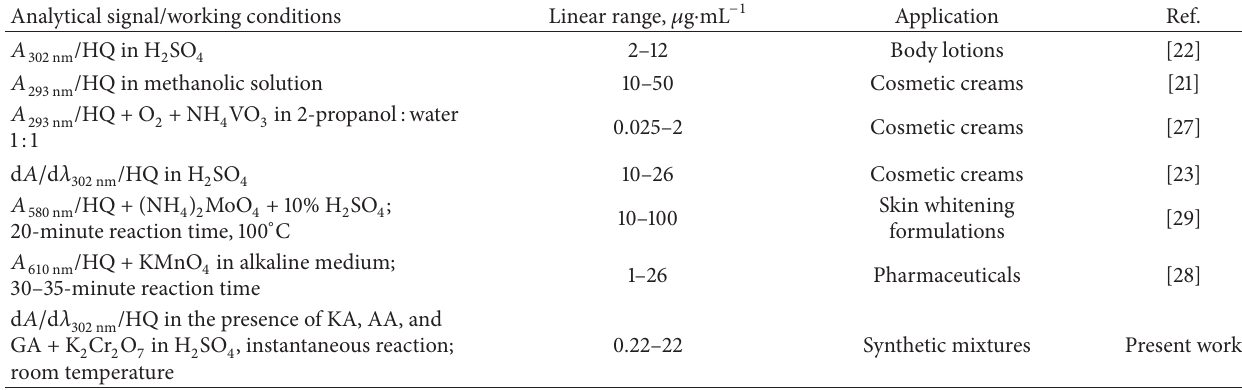
Table 2: Comparison of the proposed method with the reported spectrometric methods for HQ determination.